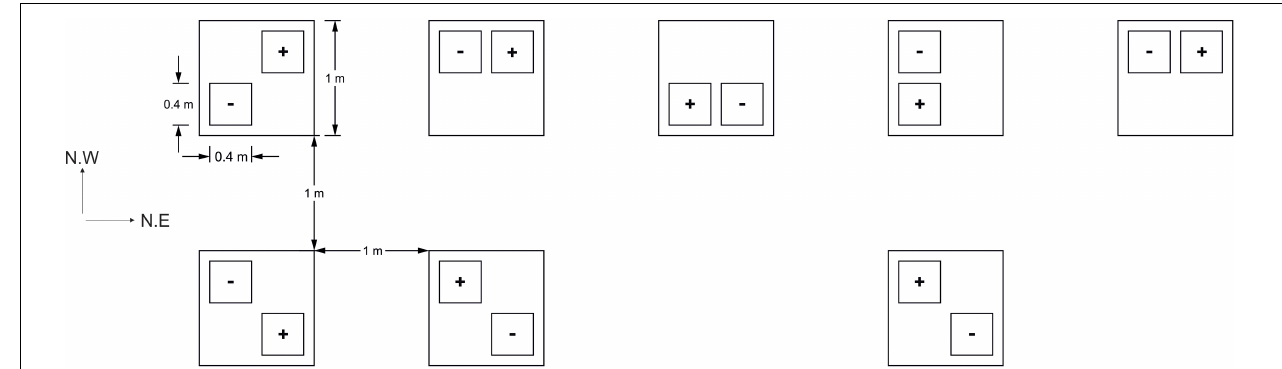
FIGURE 1 | Field plot layout (3 m × 9 m). Plots of barley with (+) or without (–) aphids, Sitobion avenae , were arranged randomly in space within one of eight blocks (large squares) which were situated 1 m from each other. Plots were assigned a quarter of each block at random in order to reduce any positional bias within each block. The field site stood on a North West slope (NW direction of the site), and two rows were arranged perpendicular to this slope (in the North East direction; NE direction of the site).